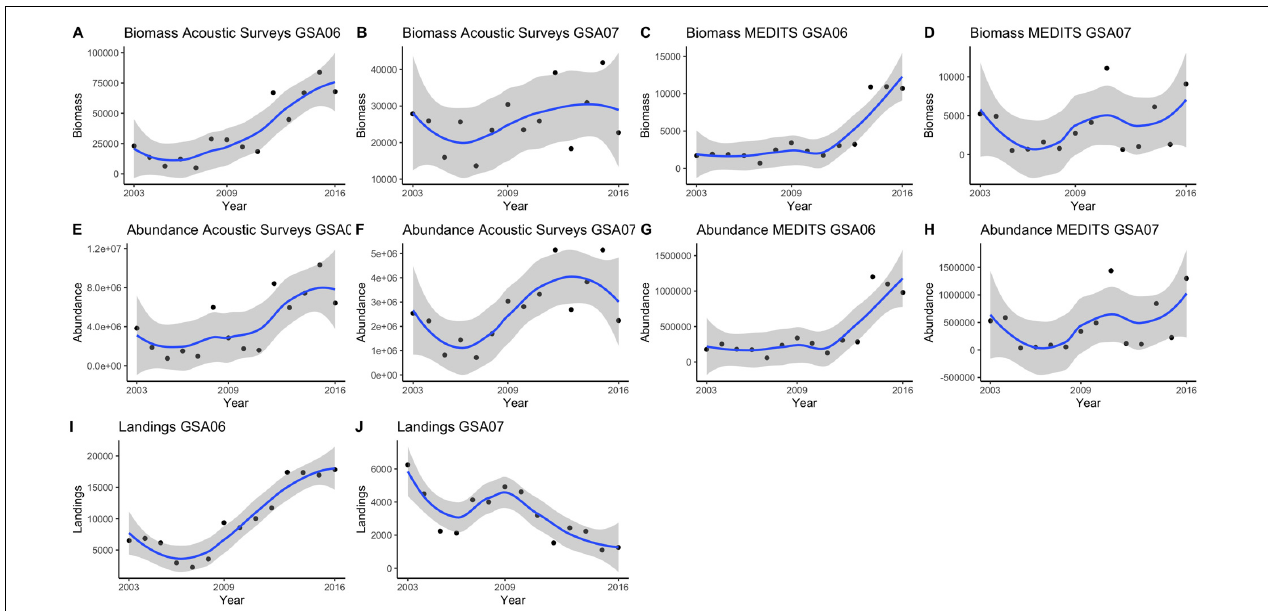
FIGURE 4 | Biomass (A–D) , abundance (E–H) , and landings (I,J) temporal trends from acoustic (ECOMED, PELMED, MEDIAS) and demersal (MEDITS) surveys and official countries landings for European anchovy ( Engraulis encrasicolus ) in the Geographical Sub-Area 06 and 07 from 2003 to 2016.